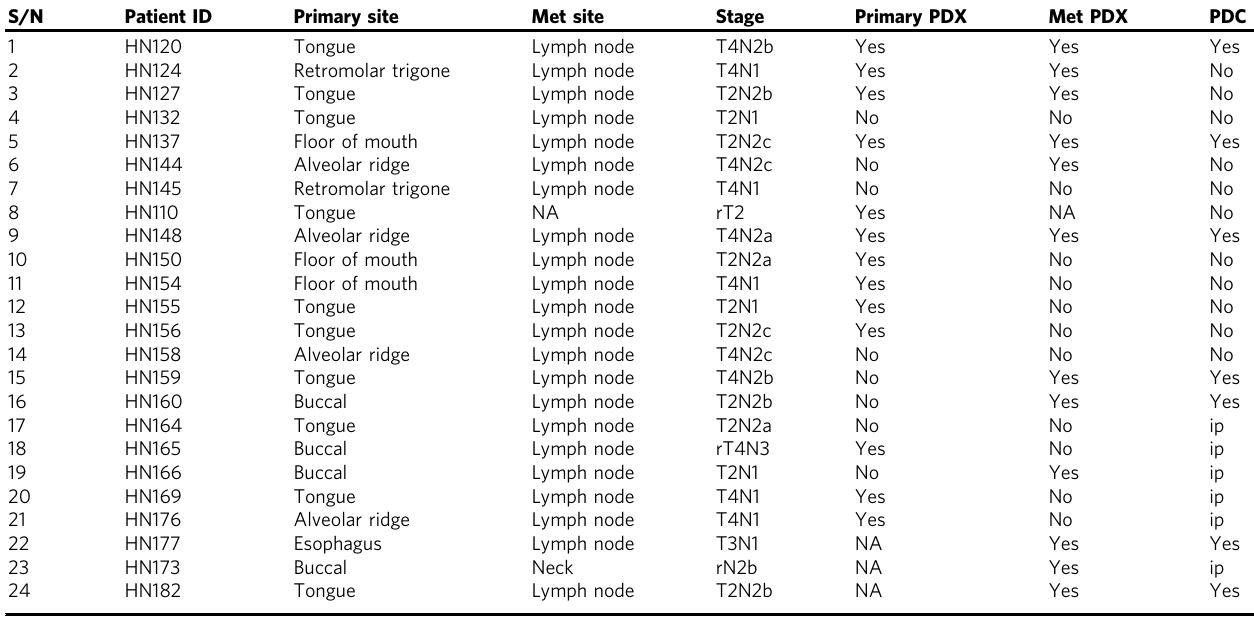
Table 1 Patients recruited for this pipeline, patients ’ tumour staging, sites of tumour resection and availability of matched PDXs and